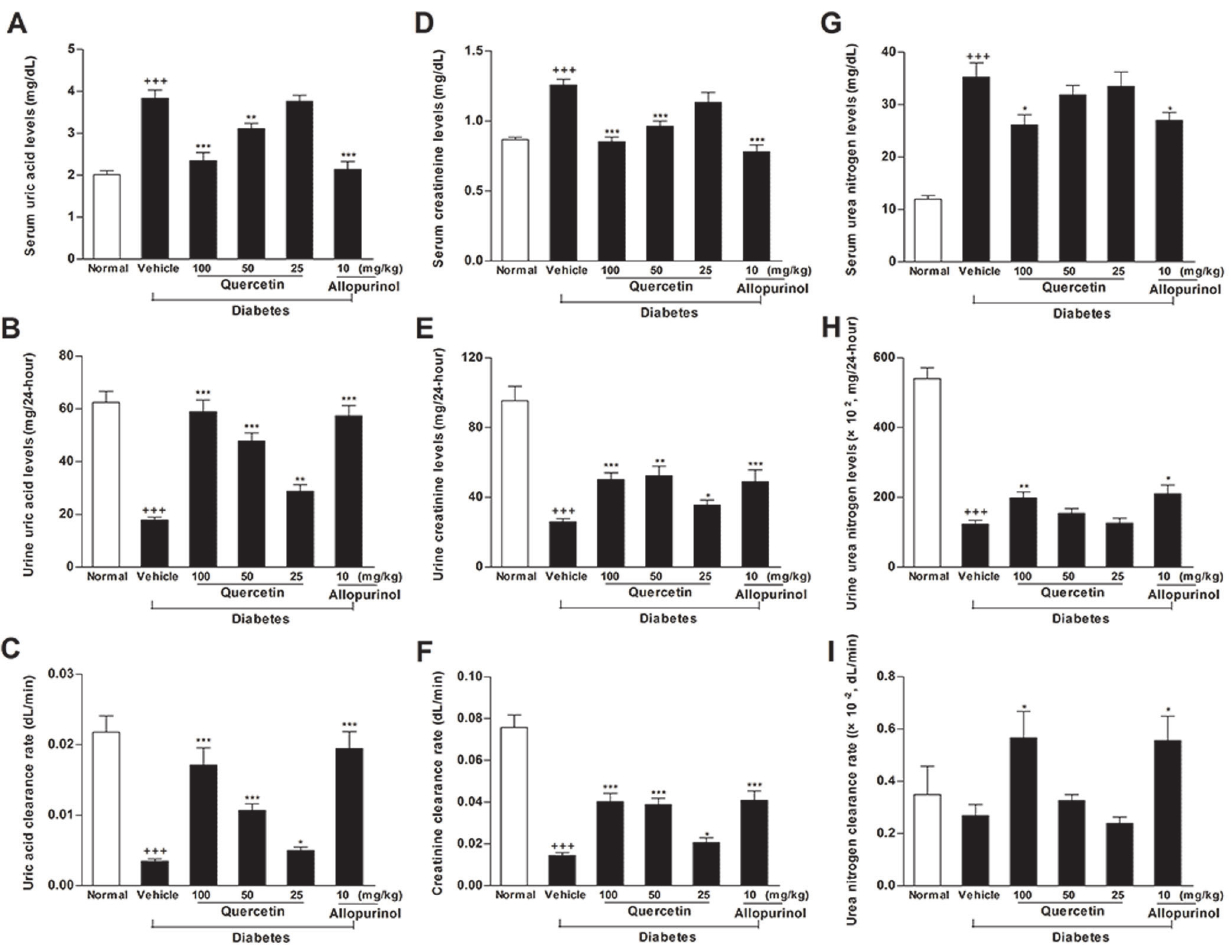
Figure 1. Quercetin and allopurinol restore streptozotocin (STZ)-induced hyperuricemia and kidney dysfunction in rats. Biochemical analyses showed uric acid (A-C), creatinine (D-F) and urea nitrogen (G-I) levels in serum and urine, as well as their clearance rates at 7 weeks after STZ injection in different groups of rats as indicated. The data are expressed as the means 6 SEM (n=8). +++ P , 0.001 versus normal control; * P , 0.05, ** P , 0.01, *** P , 0.001 versus STZ control.